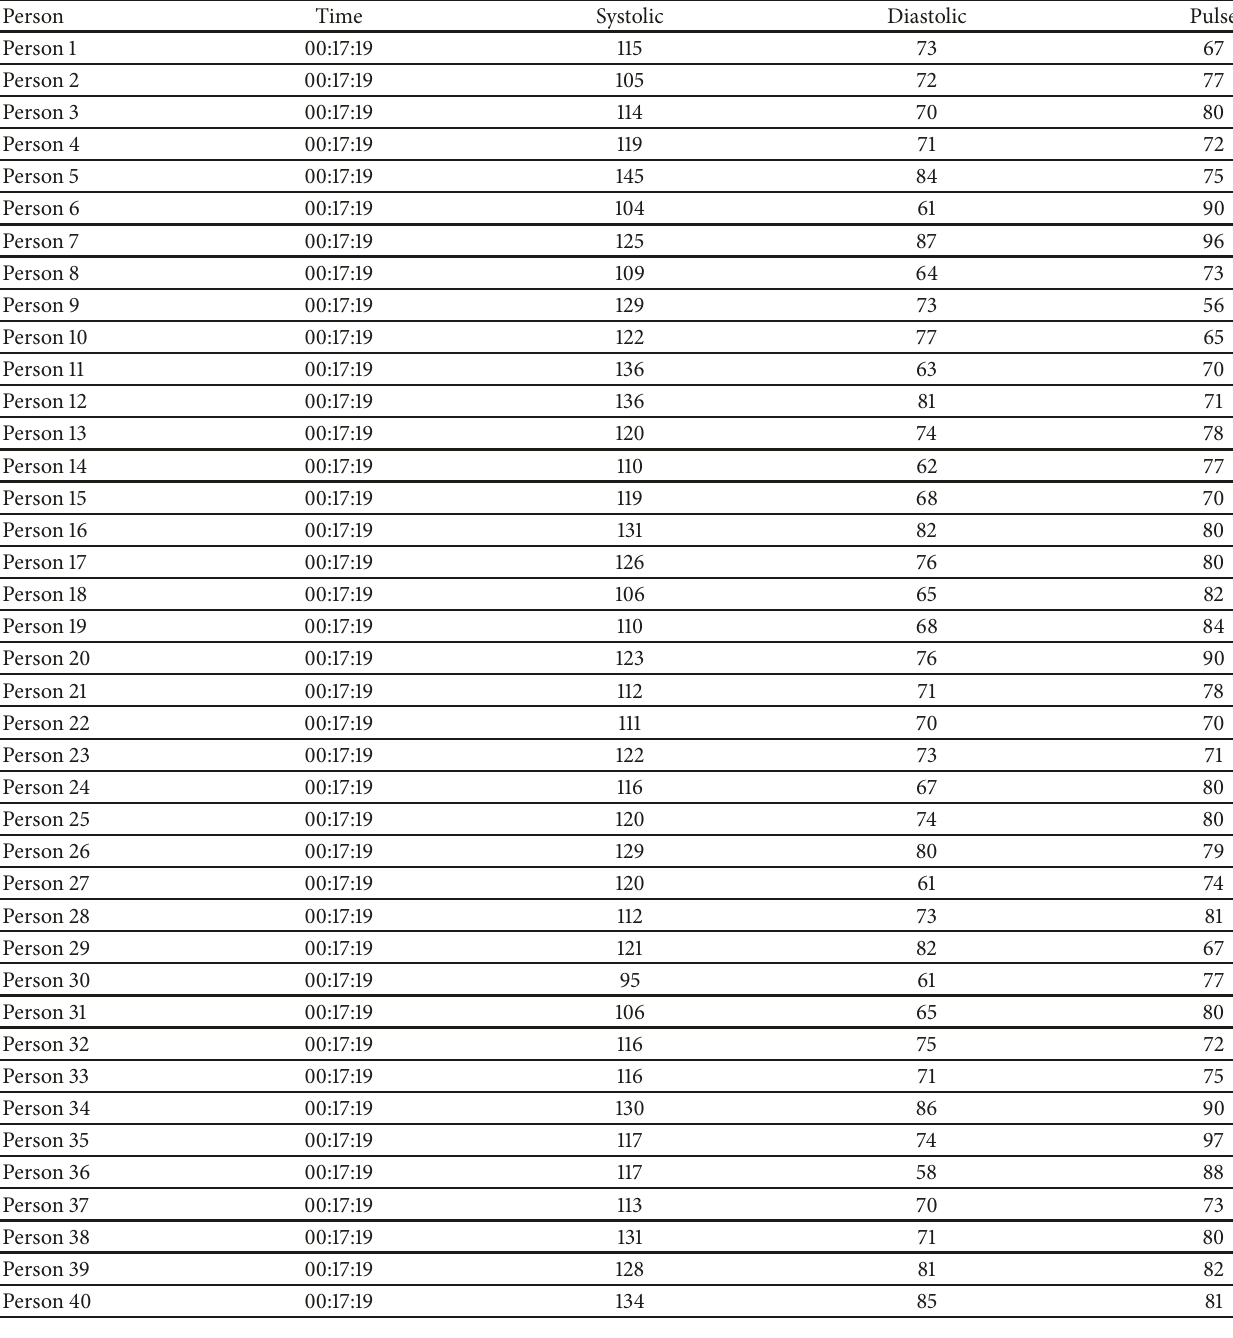
Table 6: Average of the MNN with